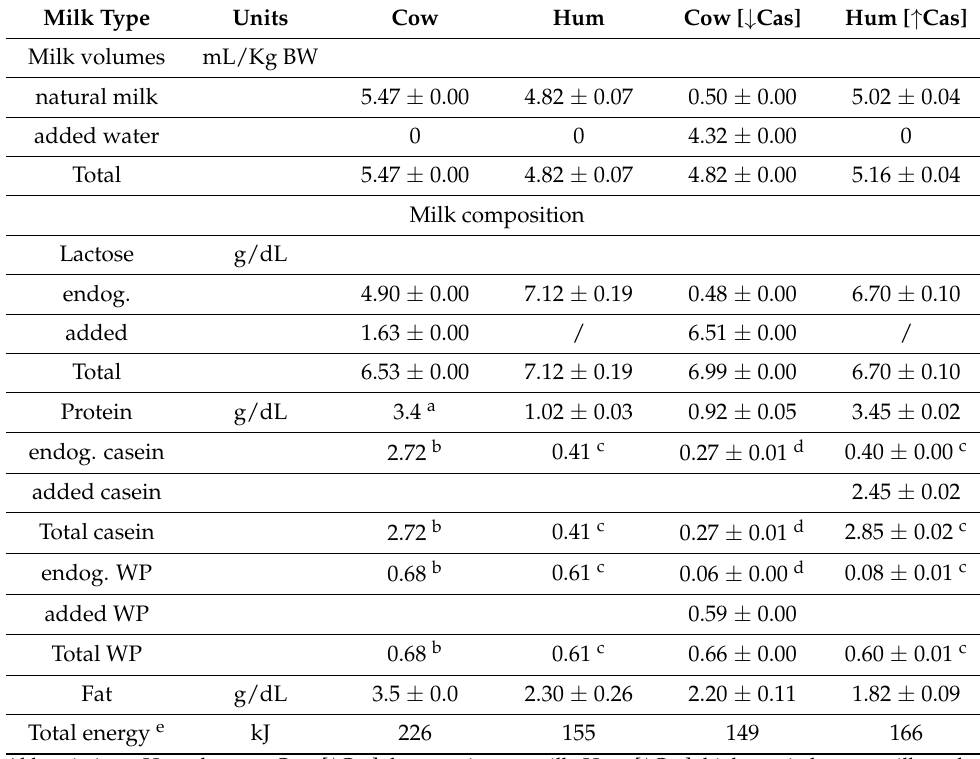
Table 1. Volumes and composition of the four milk types employed in the